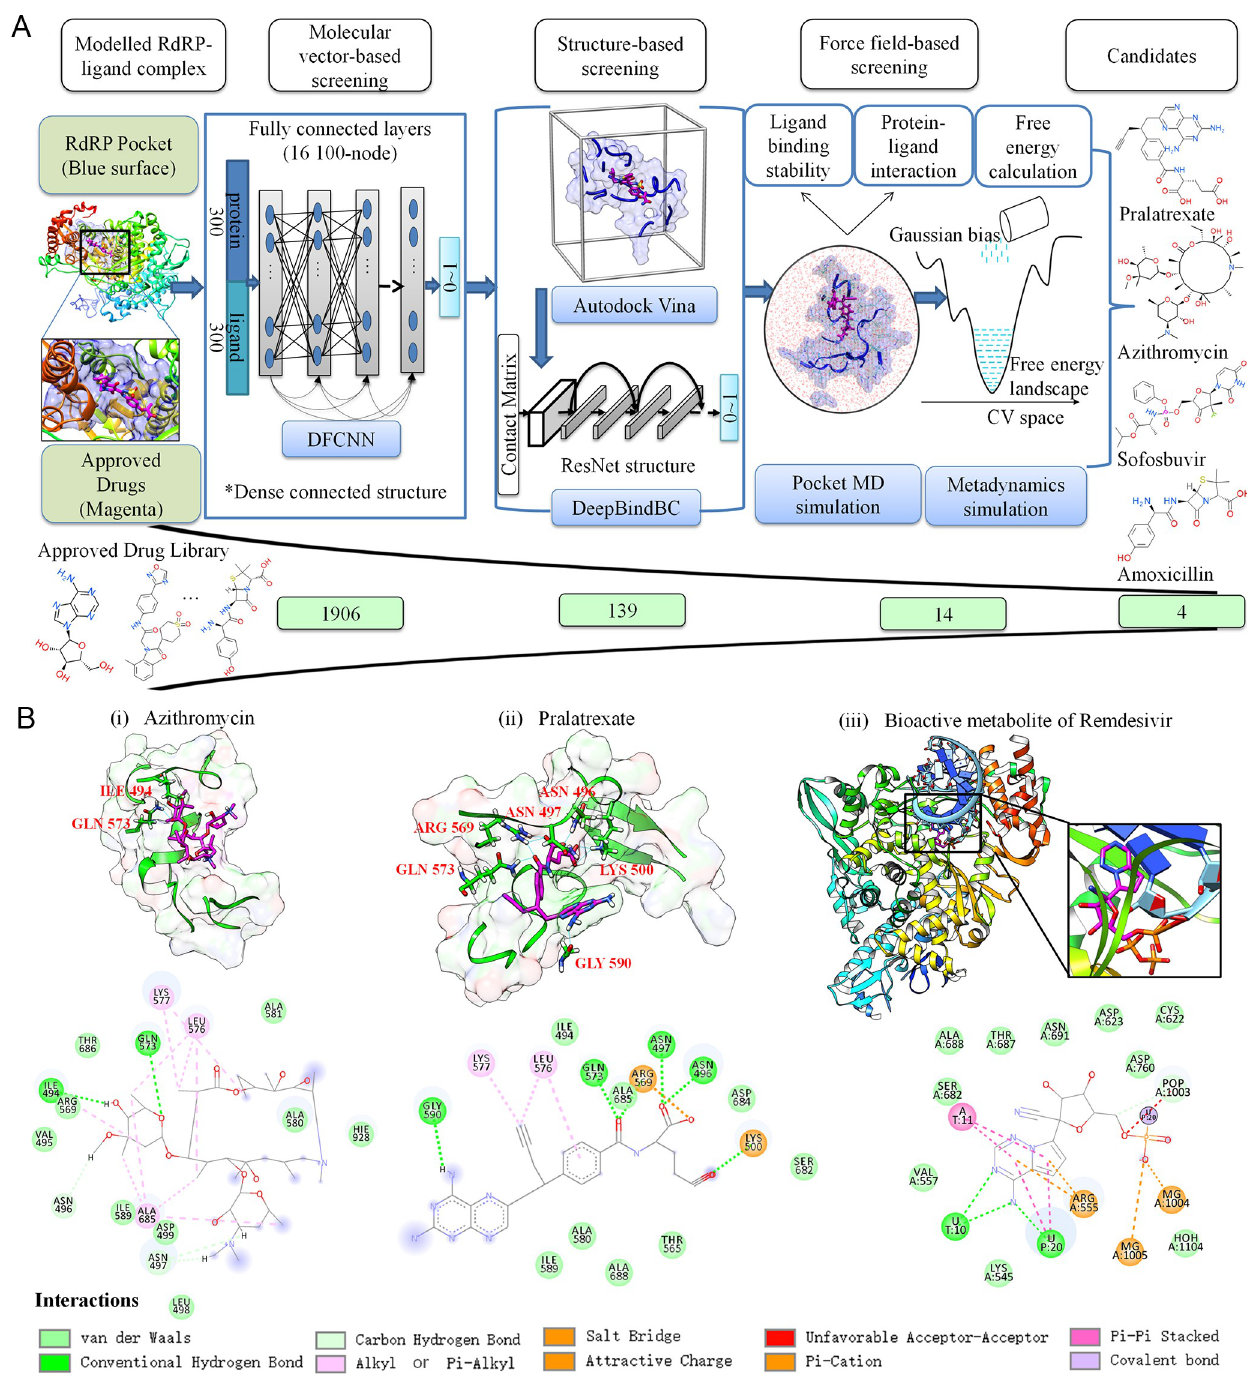
Fig 1. Drug repurposing against RdRp for COVID-19 using a hybrid deep learning and molecular simulation strategy. A, 1906 approved drugs were subject to the proposed screening process which consists of molecular vector-based screening, structure-based screening and force field-based screening. DFCNN and DeepBindBC are both deep learning-based methods. 4 candidate drugs were selected by the proposed method, including Pralatrexate, Azithromycin, Sofosbuvir, Amoxicillin. B, Key interactions between the studied drugs and RdRp from the last frame of MD simulation, for (i) Azithromycin and (ii) Pralatrexate. RdRp binding pocket is shown in green with surface representation and the corresponding drugs are shown in magenta. The 2D Schematic diagram of drug-RdRp interaction is given bottom, and neighbor residues (within 4 Å of the drug) are shown. B(iii), the experimental structure of Remdesivir in its monophosphate form with RdRp (PDB ID 7BV2), the 2D Schematic diagram of the interaction was also shown.